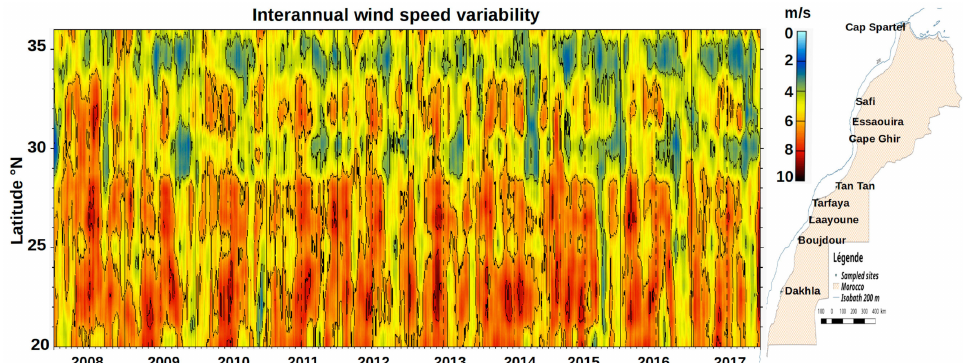
Figure 6. Space-time Hovmoller plot, illustrating the seasonal and interannual variability of the wind intensity from January 2008 to December 2017.